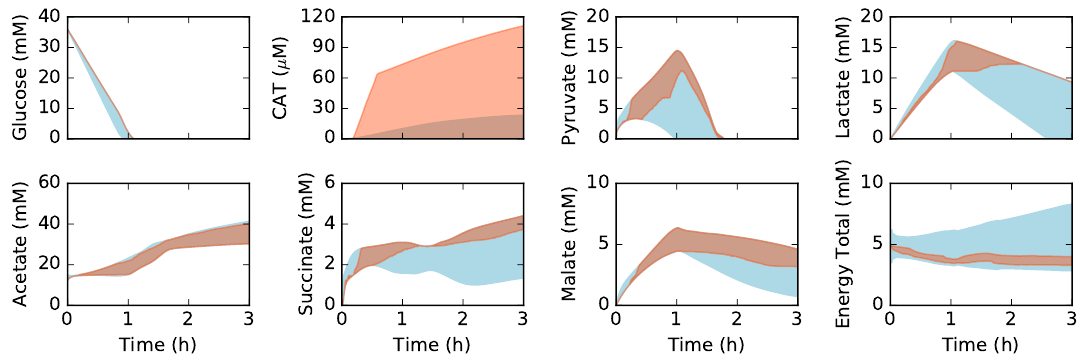
Figure 2. Simulated metabolite concentration versus synthetic data as a function of time. Central carbon metabolism, including glucose (substrate), chloramphenicol acetyltransferase (CAT) (product), and intermediates, as well as total concentration of energy species (energy total). The energy total denotes the summation of all energy species in the model (all bases and all phosphate states). The 95% confidence interval for the simulation conducted over the ensemble of transcription/translation parameter sets is shown in the orange shaded region, while the 95% confidence interval for the synthetic constraint data is shown in the blue shaded region. The synthetic data constraints were generated from the kinetic model of Horvath et al., which was trained using experimental measurements of the system simulated in this study